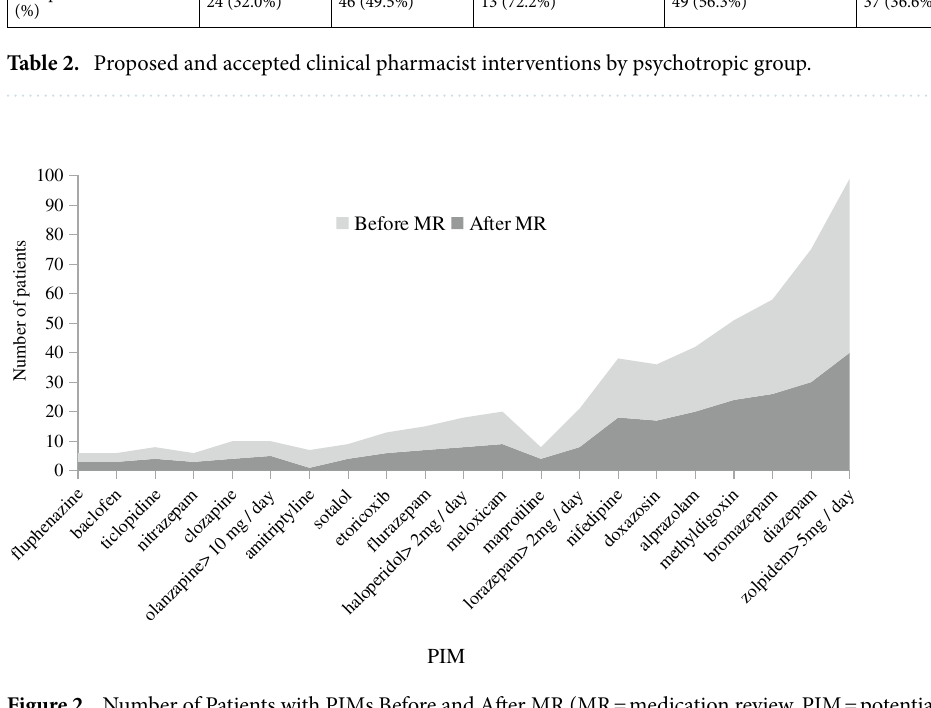
Figure 2. Number of Patients with PIMs Before and After MR (MR = medication review, PIM = potentially inappropriate medications in the